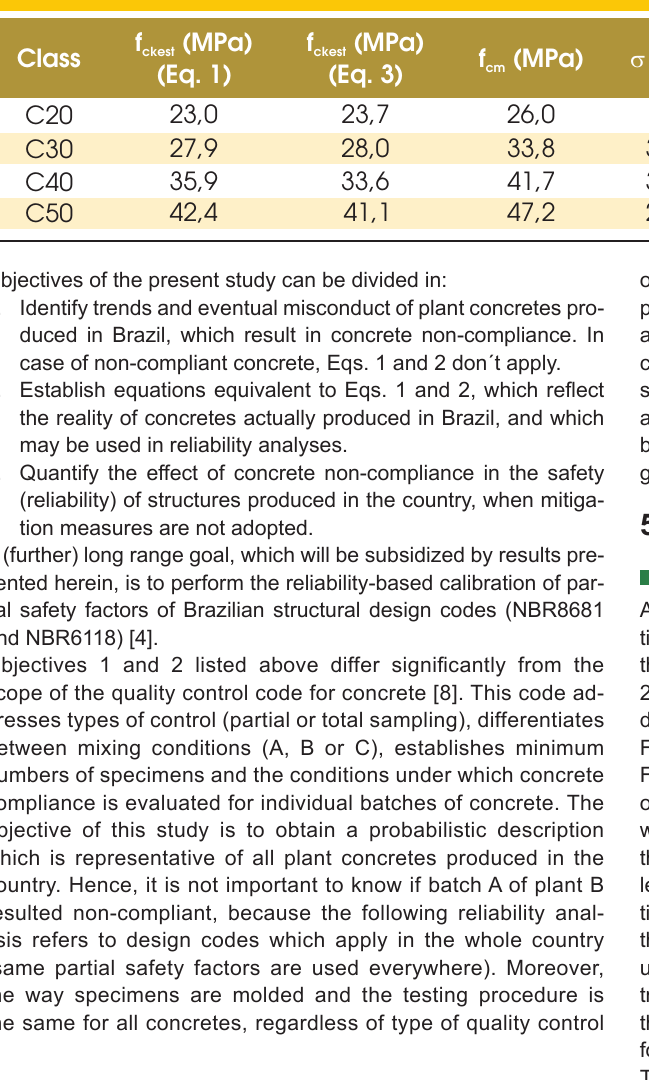
Table 2 – Results obtained from the statistical analysis of the concrete strength database